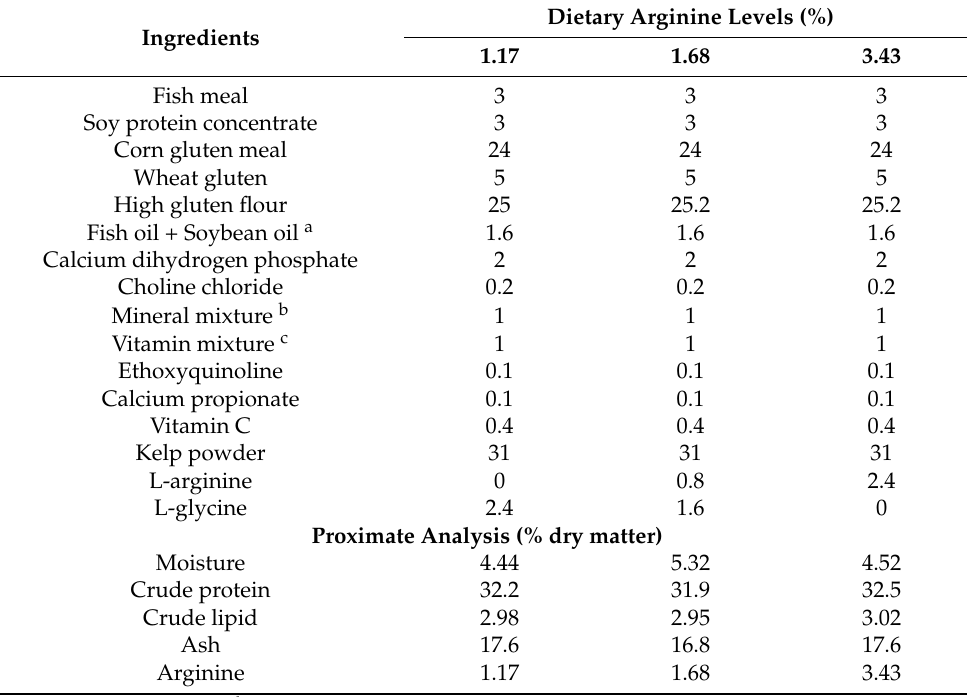
Table 4. Ingredients and proximate analysis of the experimental